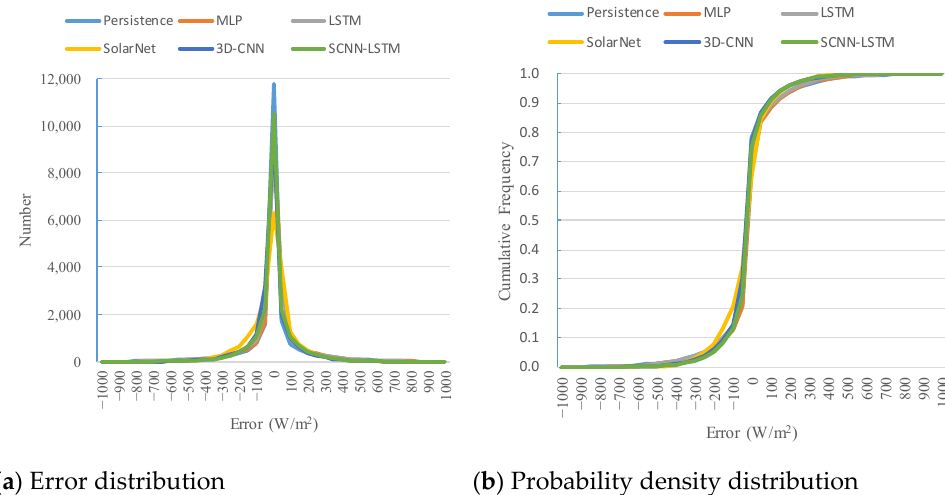
Figure 7. Distribution of the prediction errors of the forecast models in Table 4.